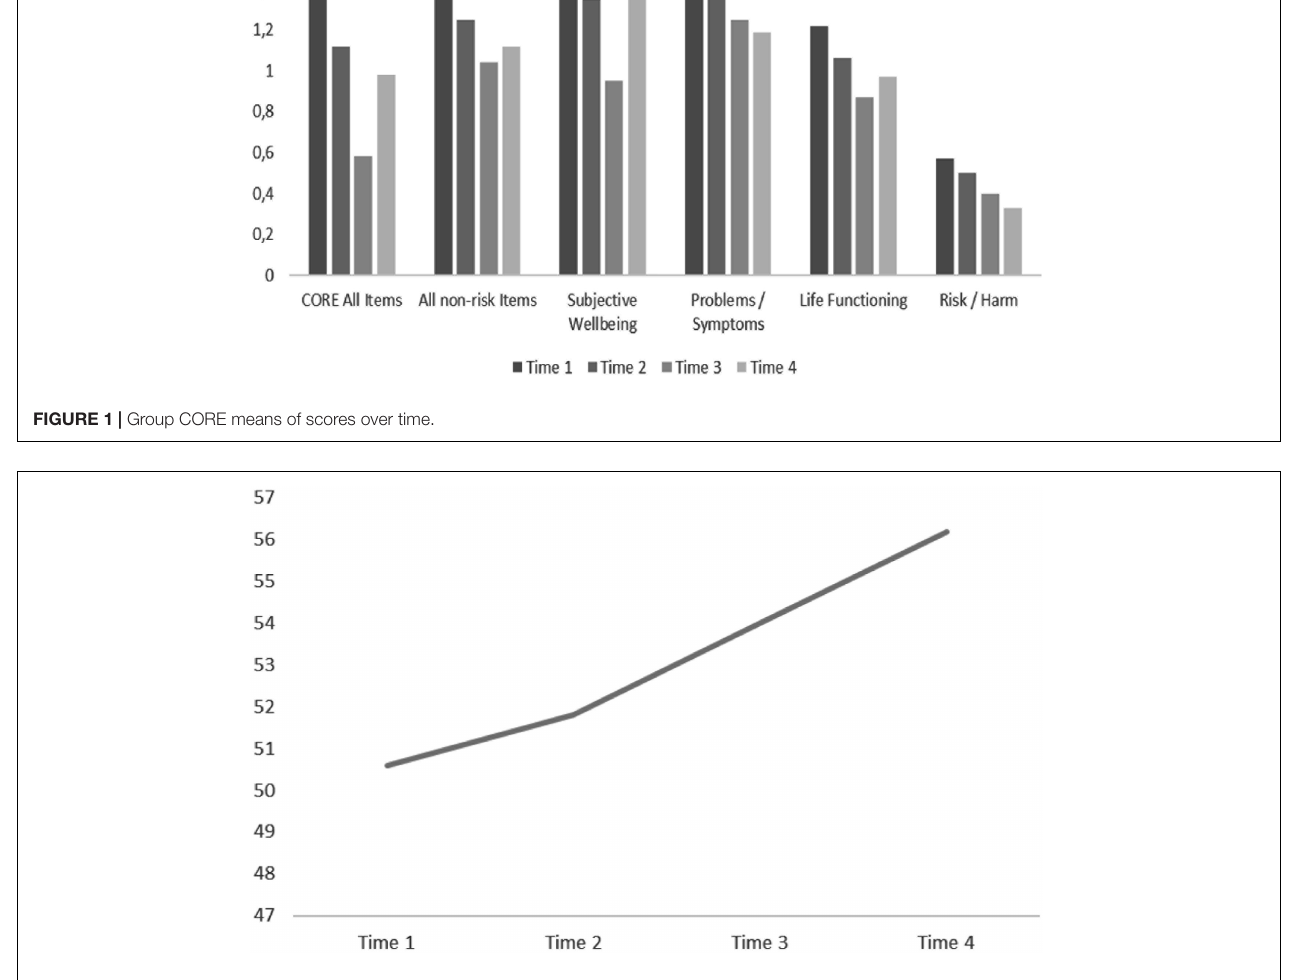
FIGURE 2 | Group SAI-R scores over